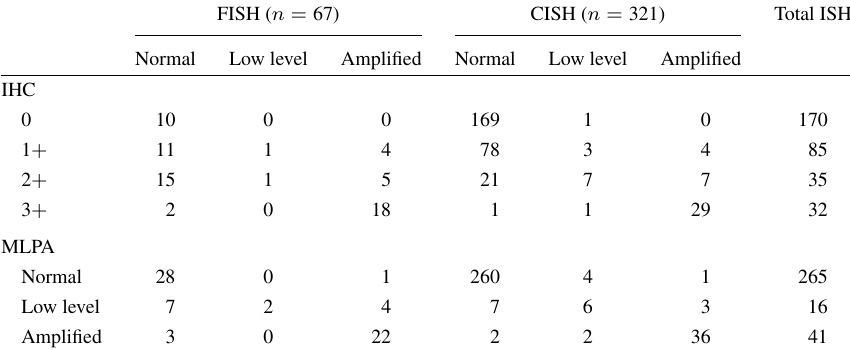
Comparison of HER-2/ neu gene amplification by fluorescence (FISH), chromogenic in situ hybridisation (CISH) and multiplex ligation-dependent probe amplification (MLPA) with immunohistochemistry (IHC) in a group of invasive breast cancer